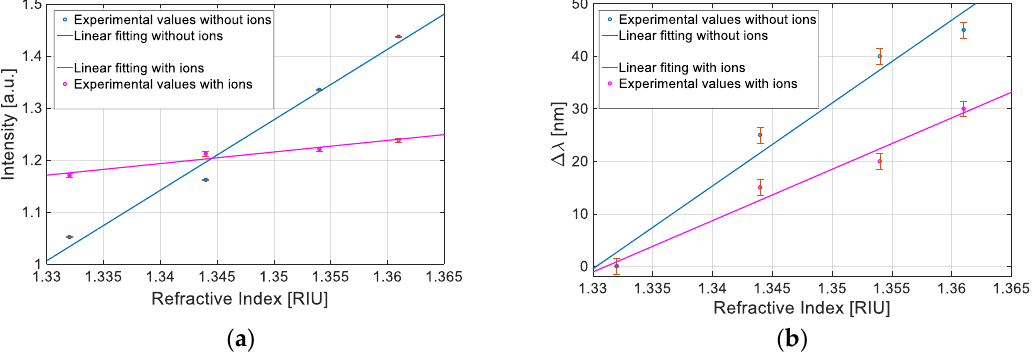
Figure 6. Comparative analysis between two configurations based with and without ILs: ( a ) Intensity value versus refractive index. ( b ) Resonance wavelength shift value versus refractive index.